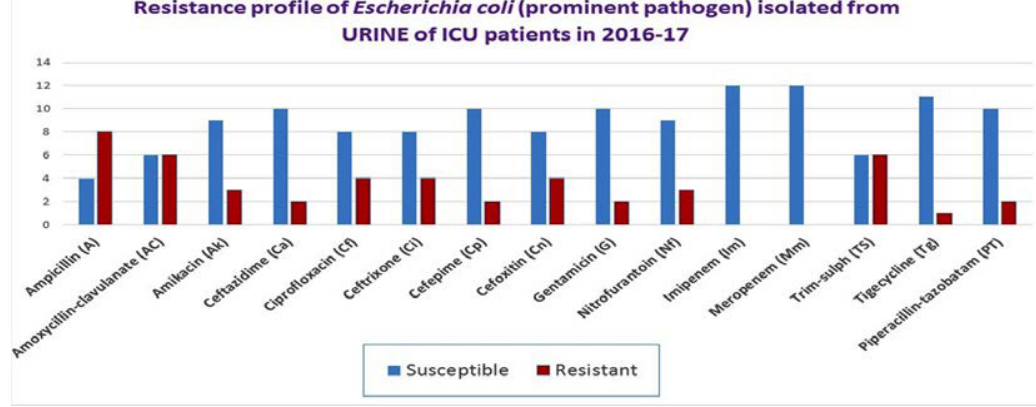
Fig. 4. Antimicrobial susceptibility trend of Escherichia coli cultured from urine of ICU patients (2016-2017)